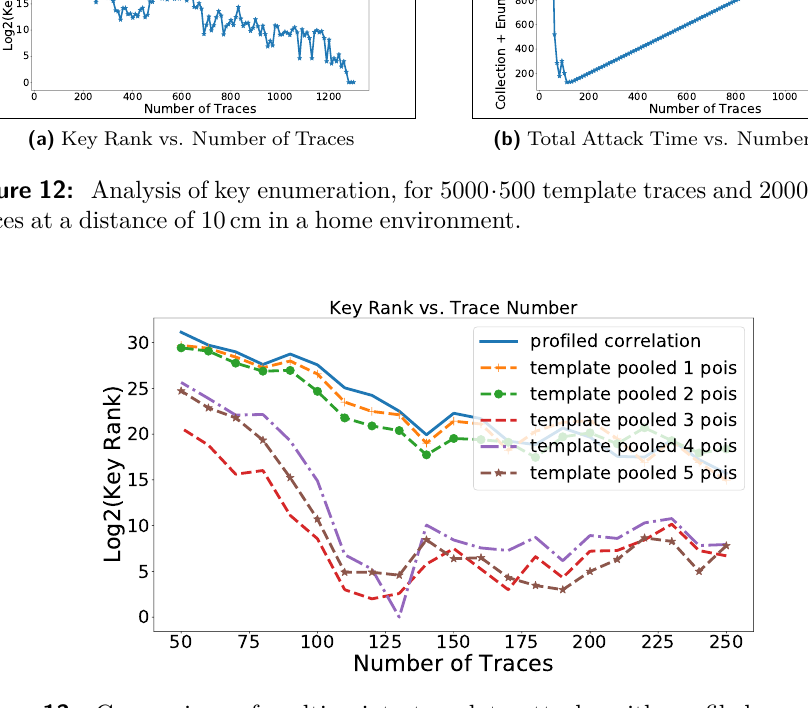
Figure 13: Comparison of multivariate template attacks with profiled correlation, for 5000 · 500 template traces and 2000 · 500 attack traces at a distance of 10 cm in a home environment The attacks with more than one POI clearly converge